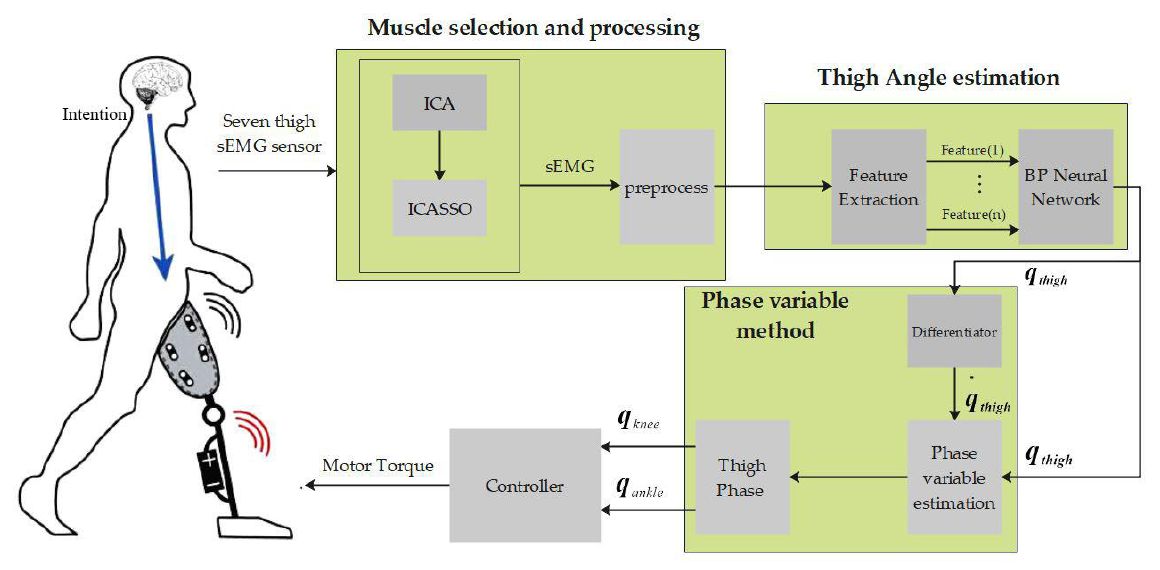
Figure 2. The novel control framework proposed in this paper.